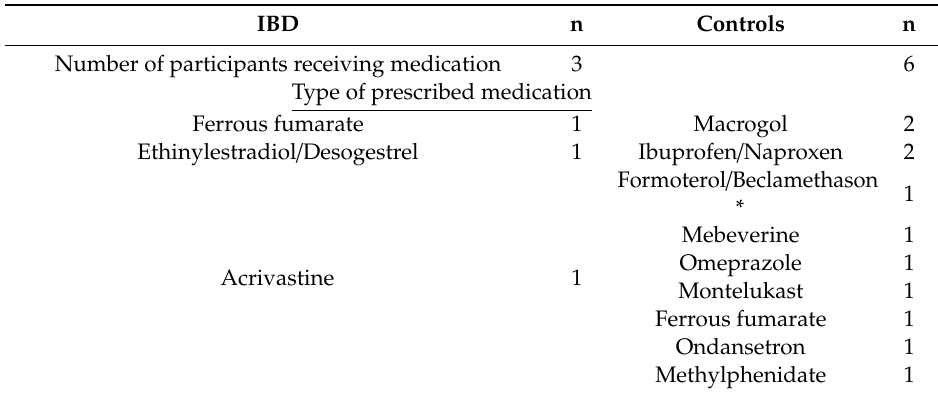
Table 3. Medication